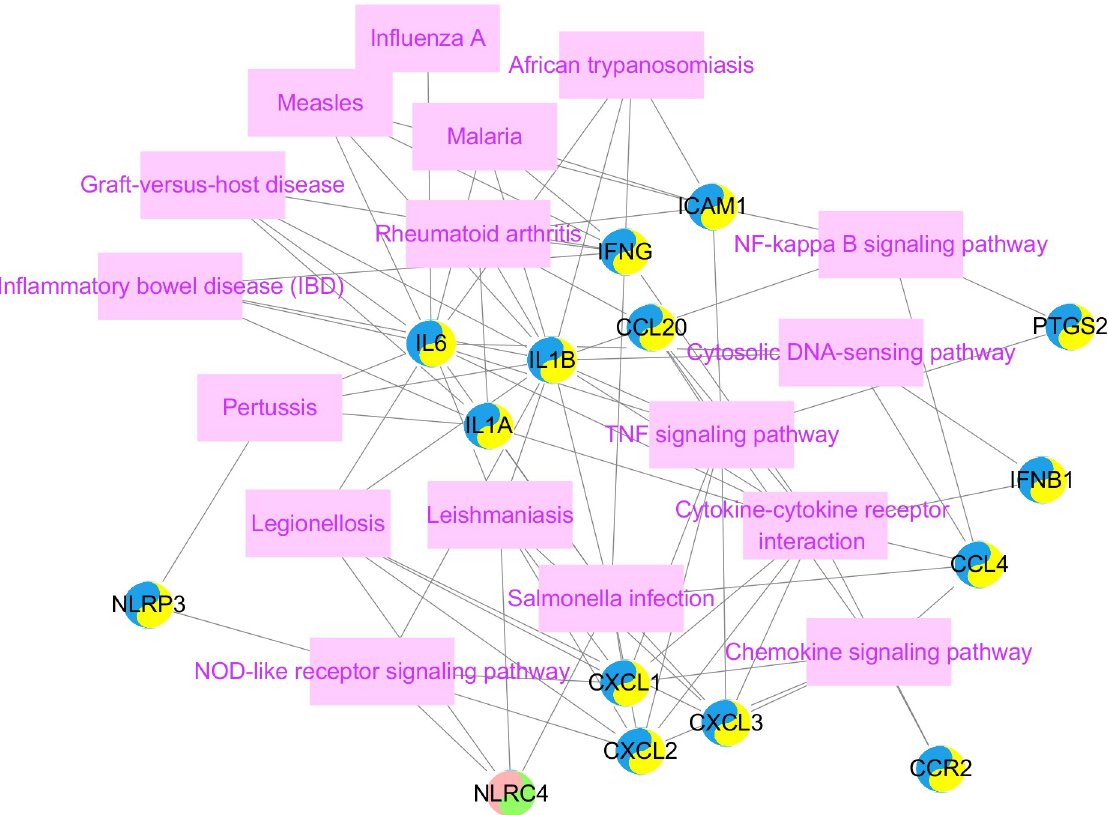
Fig 5. KEGG pathways enrichment and interrelation analysis. Coregulated DEGs were shown in a tow color circle. Pink represents upregulated DEGs in females, blue represents downregulated DEGs in females, yellow stands upregulated DEGs in males, green represents downregulated DEGs in males; pink rectangles represent enriched KEGG pathways. The protein-protein interactions were not included in the pathway and DEG interrelations.